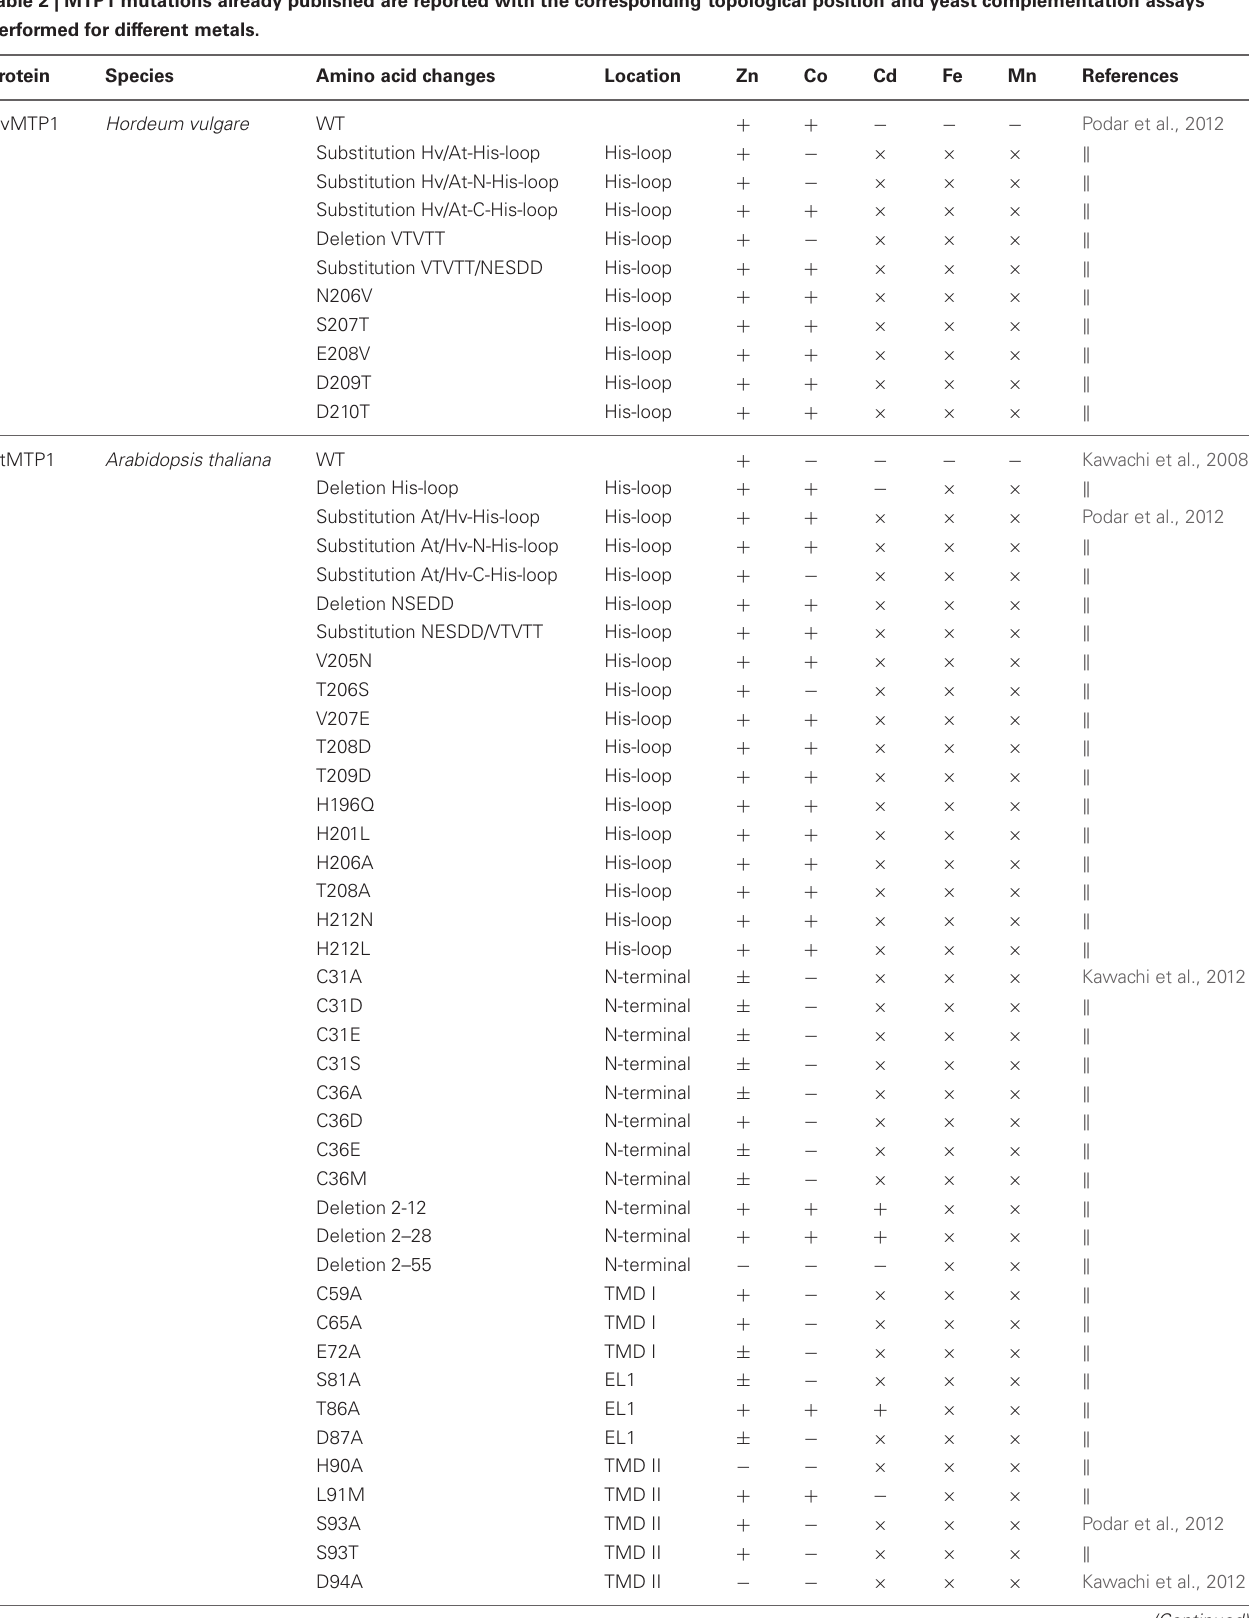
Table 2 | MTP1 mutations already published are reported with the corresponding topological position and yeast complementation assays performed for different